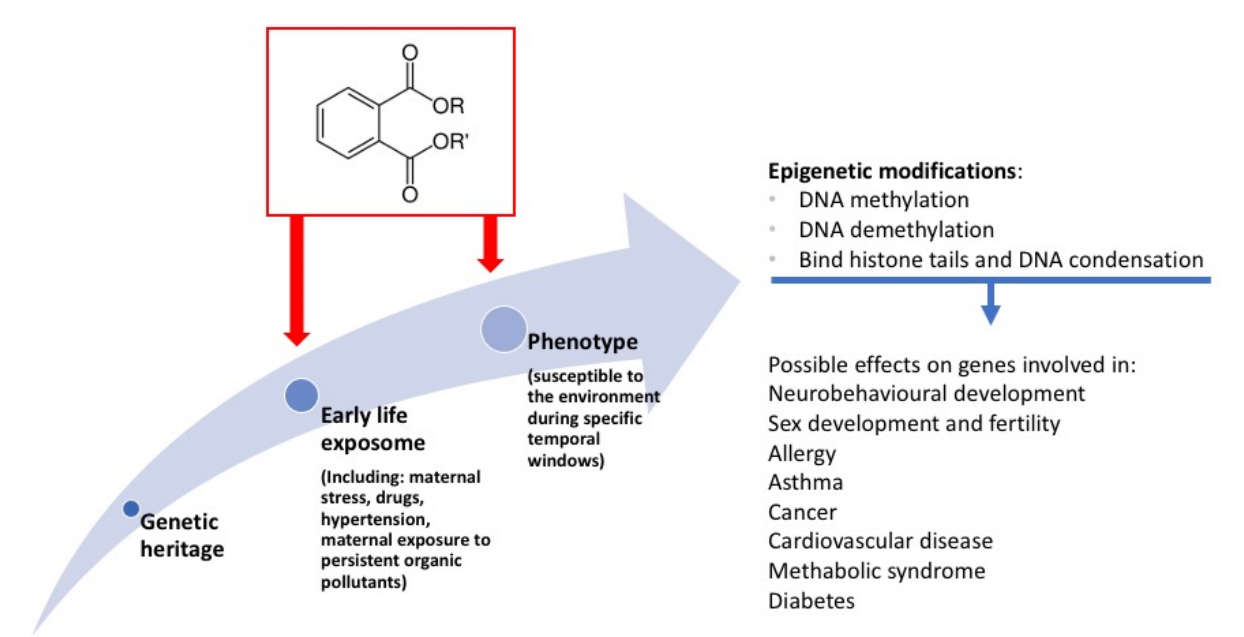
Figure 1. How phthalates may enter in The Development Origin of Health and Disease (DOHaD), causing epigenetic